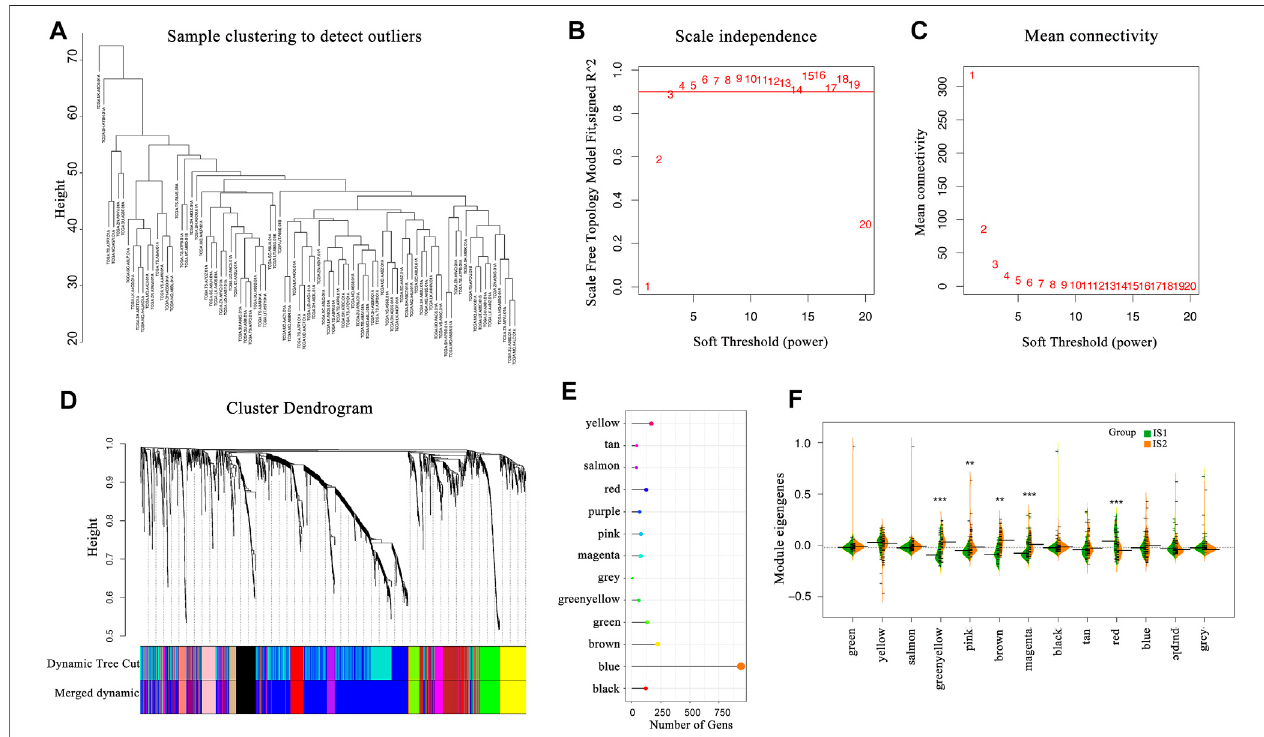
FIGURE 9 | Identi fi cation of immune-related gene co-expression modules (A – D) Gene co-expression network analysis on the basis of immune-related genes (E) The number of genes in the different modules (F) Differential distribution of feature vectors of each module in the two immune subtypes.